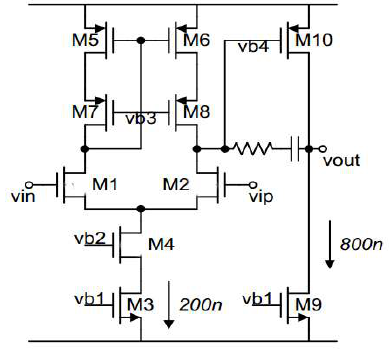
Figure 2. The schematic of the main amplifier